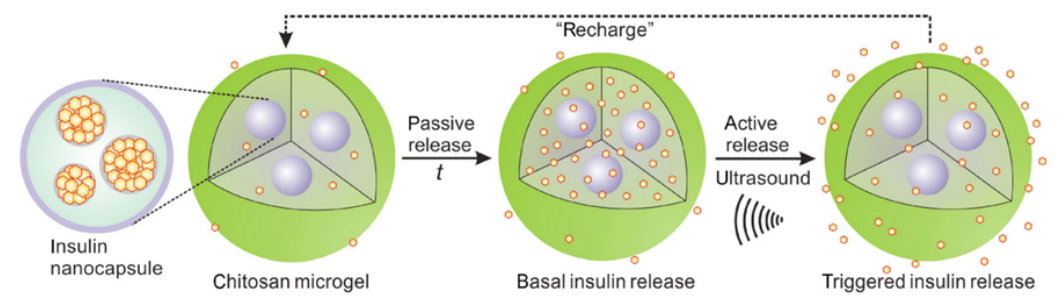
Figure 5. Schematic diagram of a CHC microgel encapsulating insulin-loaded PLGA nanocapsules. The loaded insulin has a passive and active basal drug release but is triggered and dependent on US. Adapted from [47] (Creative Common License); Published by Springer, 2017.